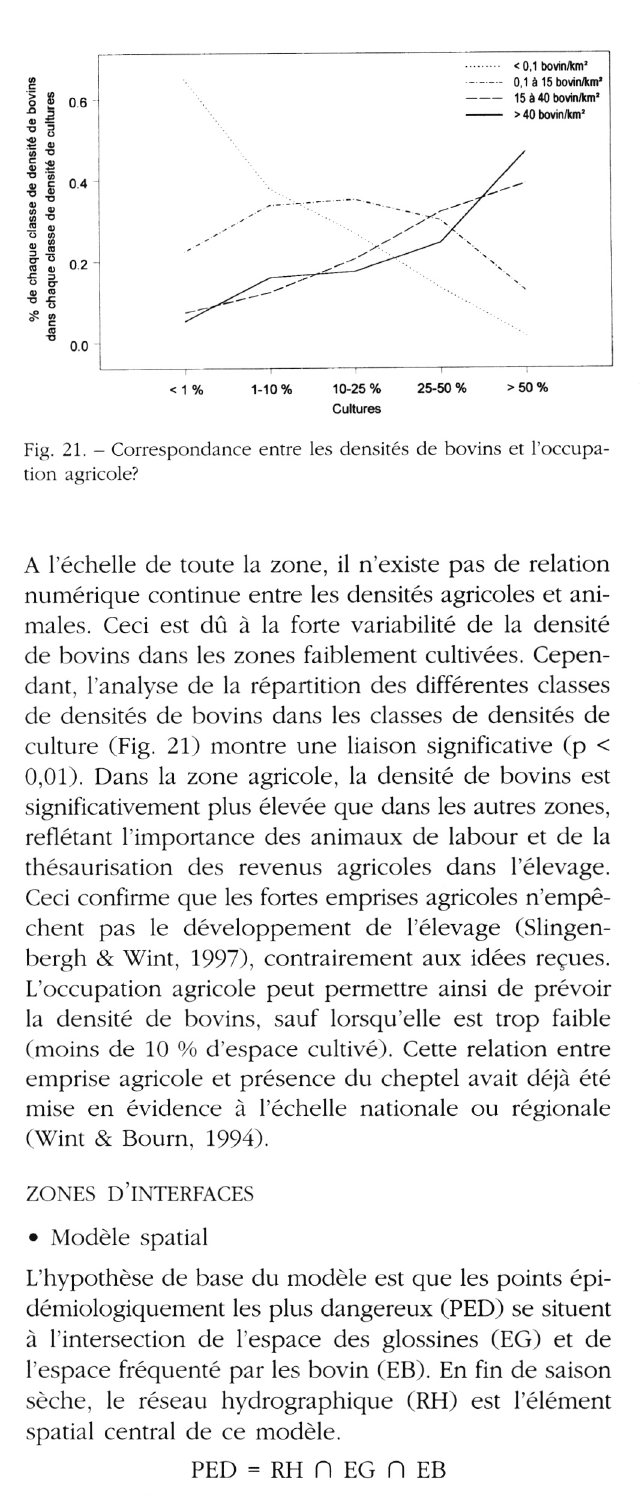
agricole, les agro-éleveurs qui possèdent des trou­ peaux de taille moyenne sont nombreux; l’accumula­ tion de ces troupeaux entraîne des densités de bovins